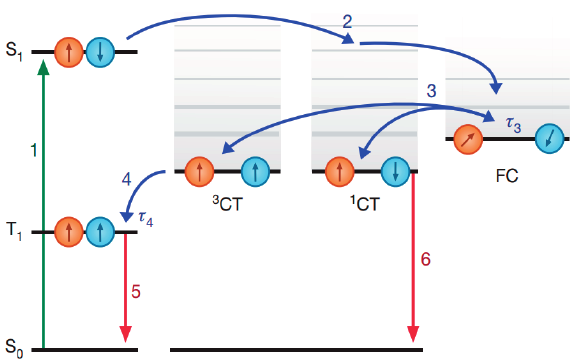
Figure 4. State diagrams representing the various photophysical processes in an OPV. Conversions between excited state species are shown in blue, and recombination channels are shown in red. Cited from [62]. Copyright 2013,